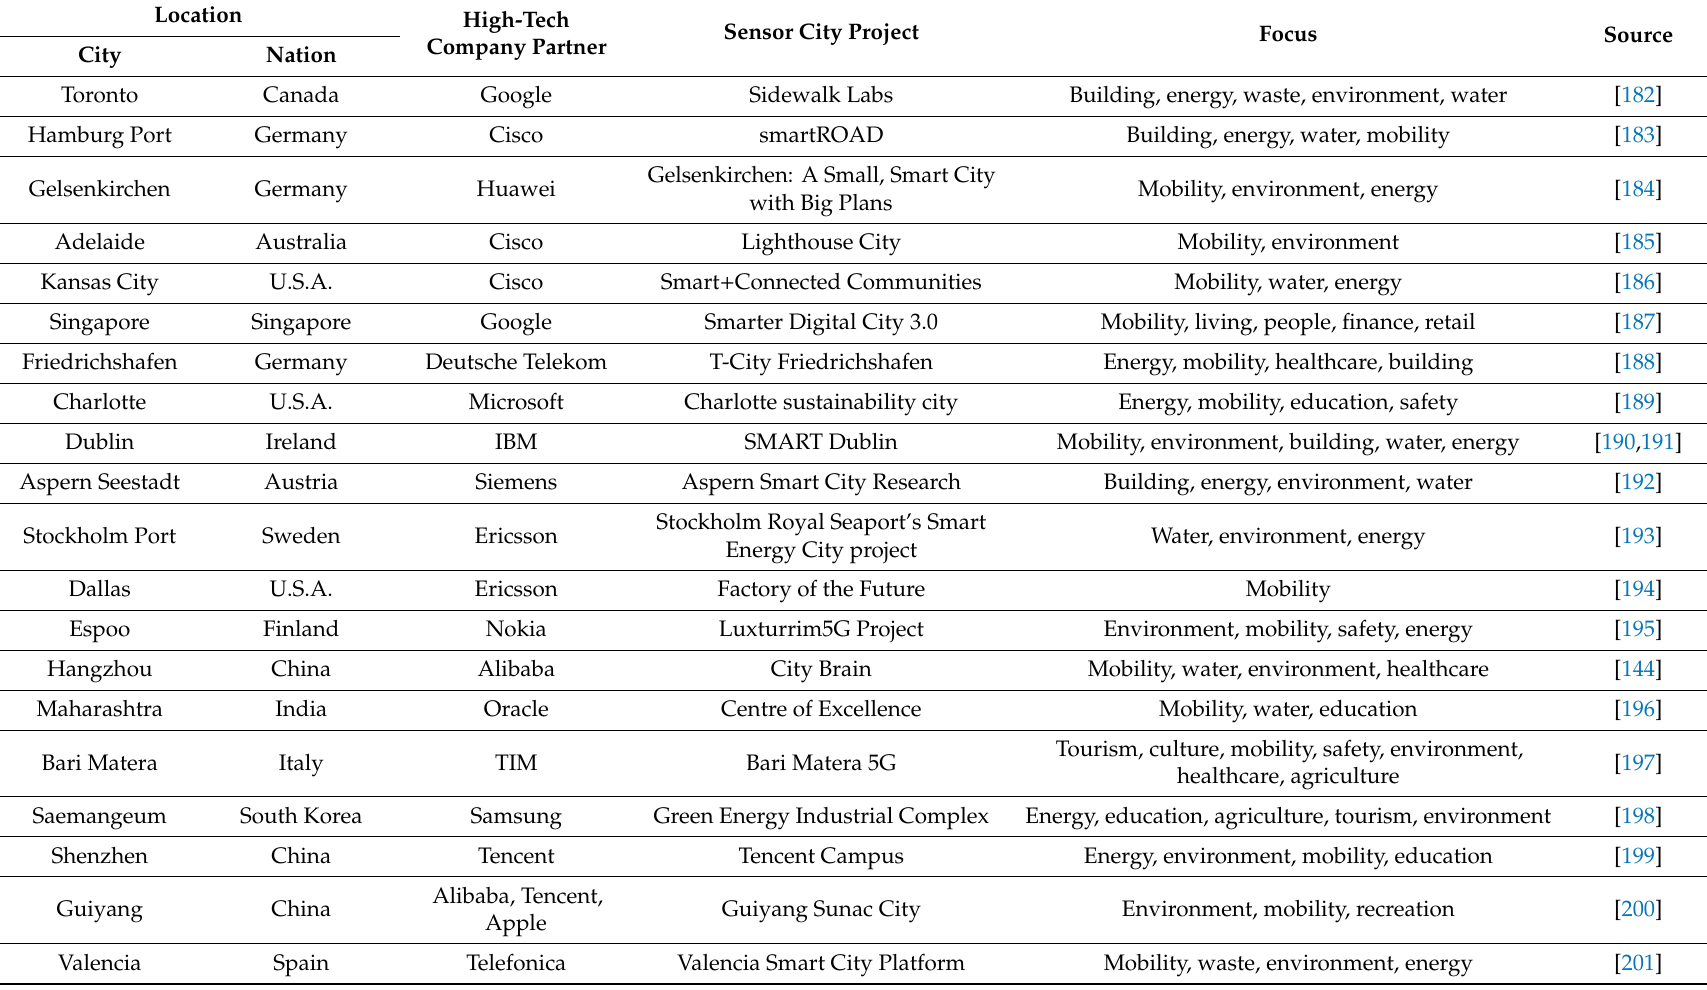
Table A1. Sensor city projects of high-tech companies investigated in this study (source: